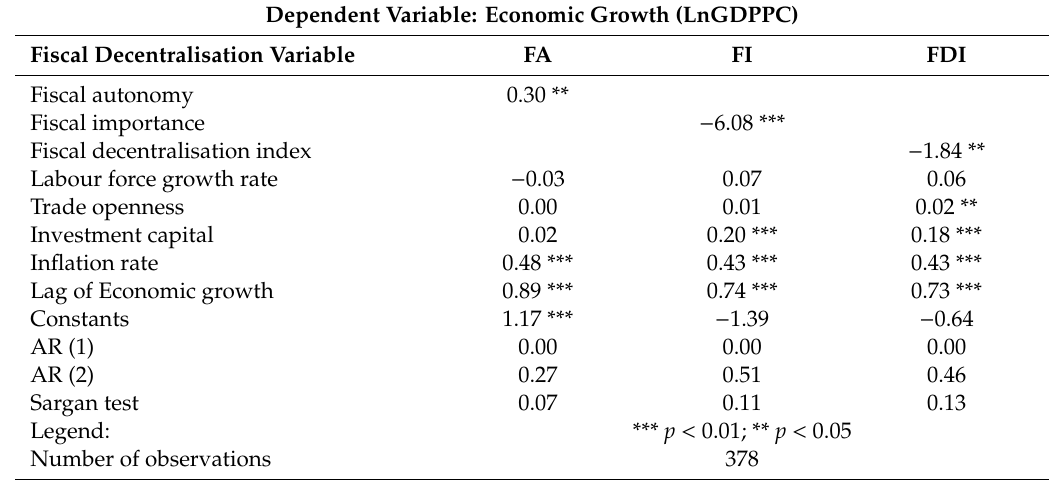
Table 4. Results (using the Di ff erence Generalized Method of Moments